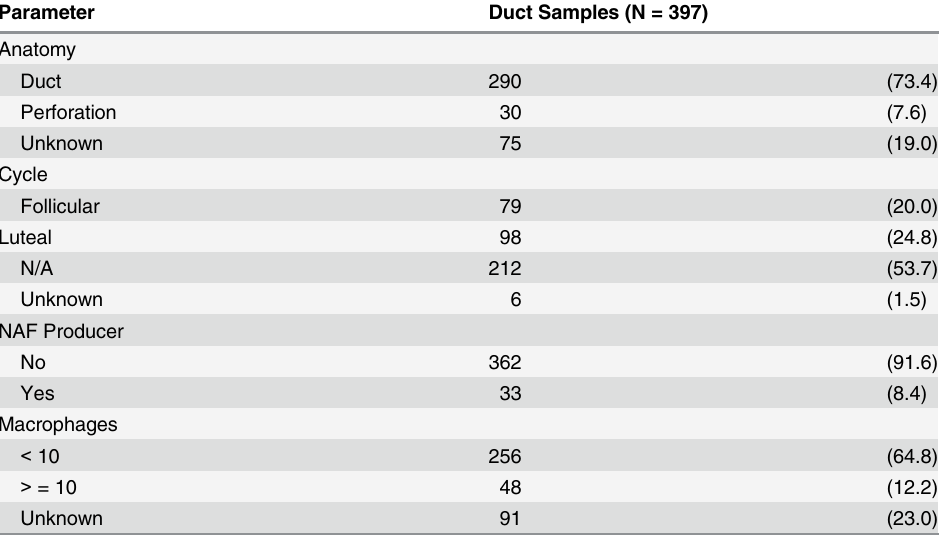
Table 2. Duct Characteristics.